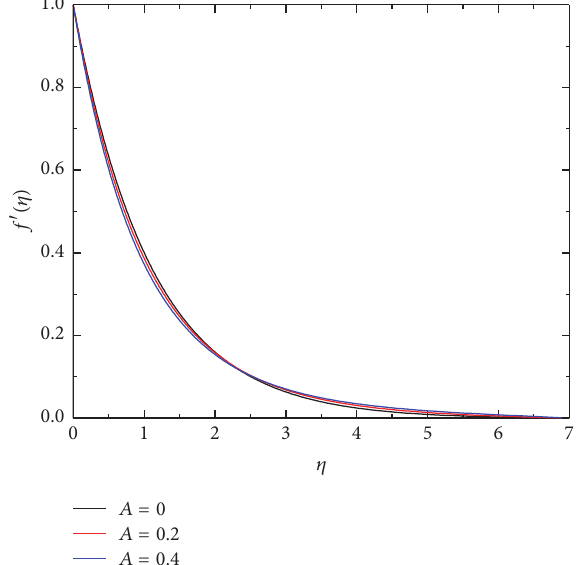
Figure 7: Temperature profiles for various values of 𝐾 when 𝐴 = 0 , 𝑅 = 0.5 , and 𝜉 = 0 .